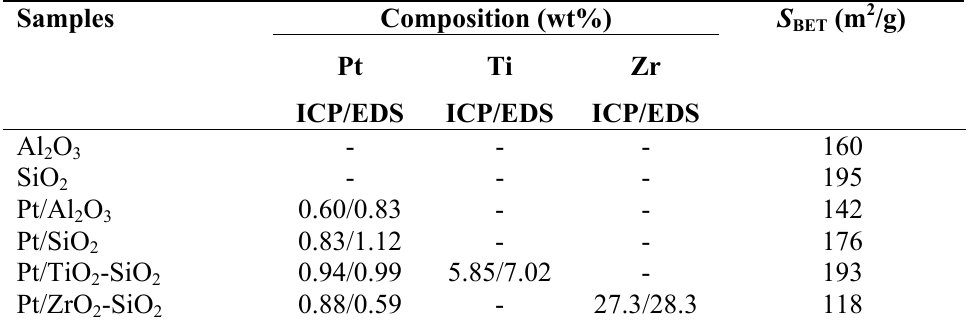
Table 1. Composition and BET surface area of the supports and Pt